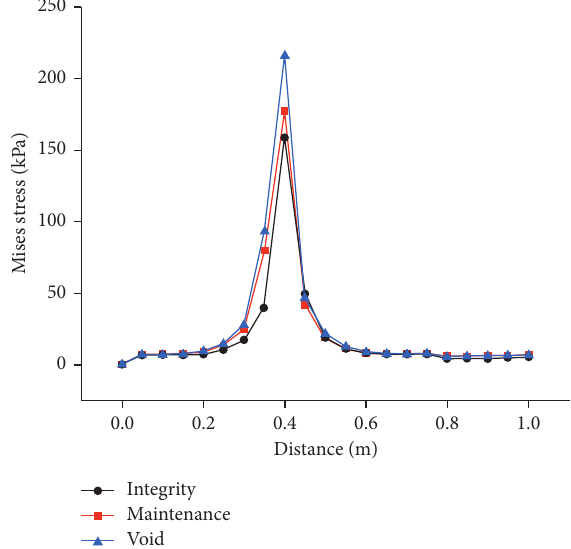
Figure 15: Mises stress comparison diagram of three working conditions.